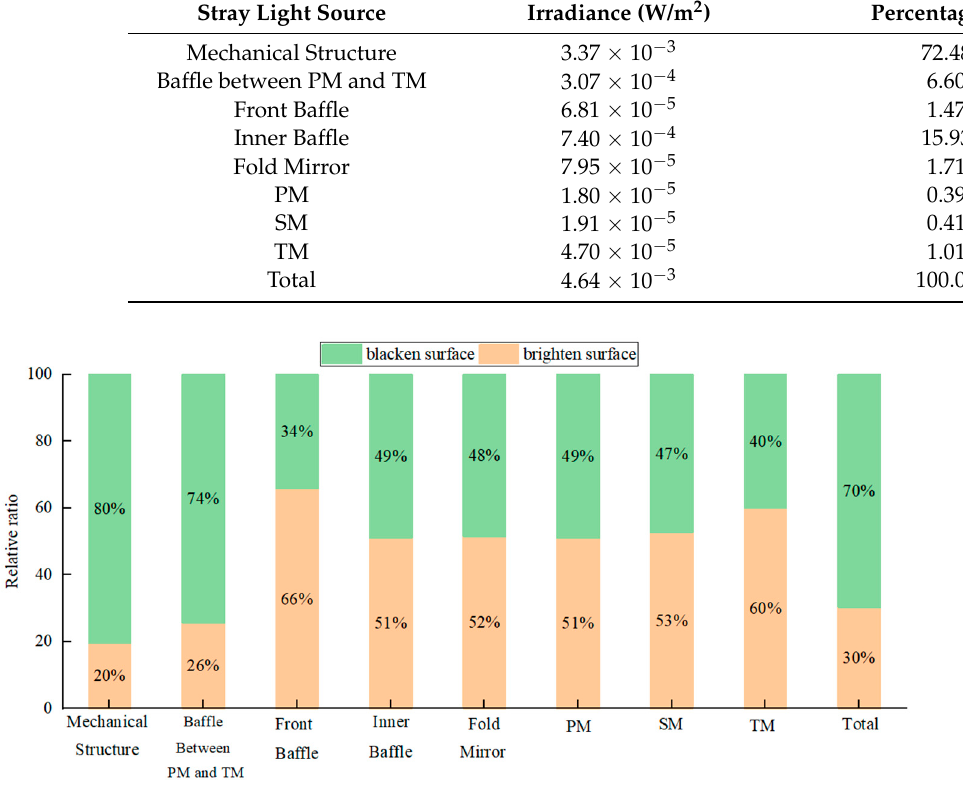
Figure 10. The relative ratio of brightened surface to blackened surface.